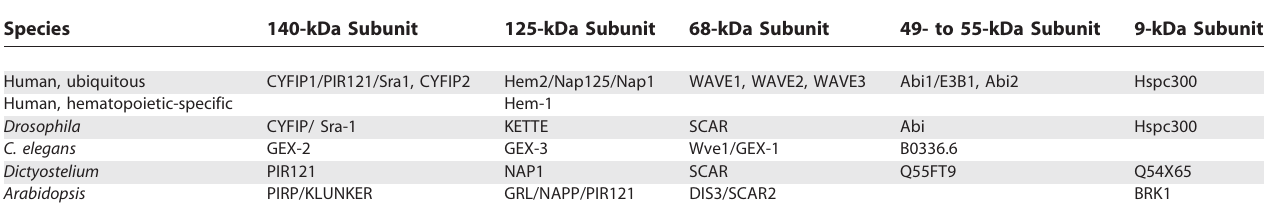
Table 1. WAVE Complex Homologs and Nomenclature in Various Species Species